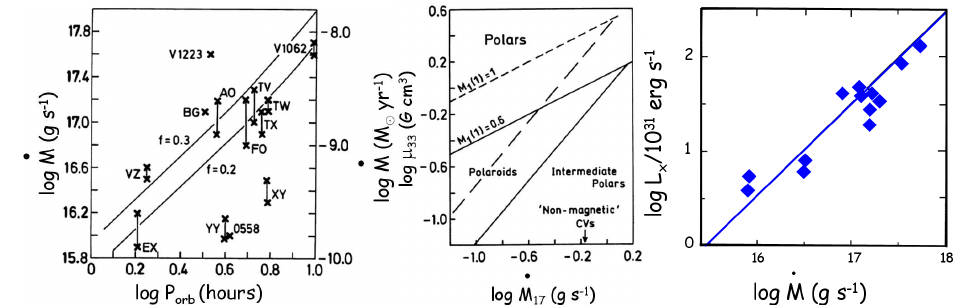
Figure 2: Left panel: Intermediate polars in the plane ˙M-P orb . The two lines are lines of disc stability: stable above and dwarf nova outburst below. They were computed for f=0.2 and 0.3, with R out = f × a, being a the separation of the two stars in the system (by courtesy of Warner, 1996). Central panel: Magnetic moment in units of 10 33 G cm 3 versus mass accretion rate in units of 10 17 g s − 1 . Boundaries for white dwarf mass M 1 = 1 M (cid:12) and M 1 = 0 . 6 M (cid:12) have been computed for P orb = 4 h (by courtesy of Warner, 1996). Right panel: Mass transfer rate onto white dwarf versus (2-10 keV) X-ray luminosity (by courtesy of Warner,